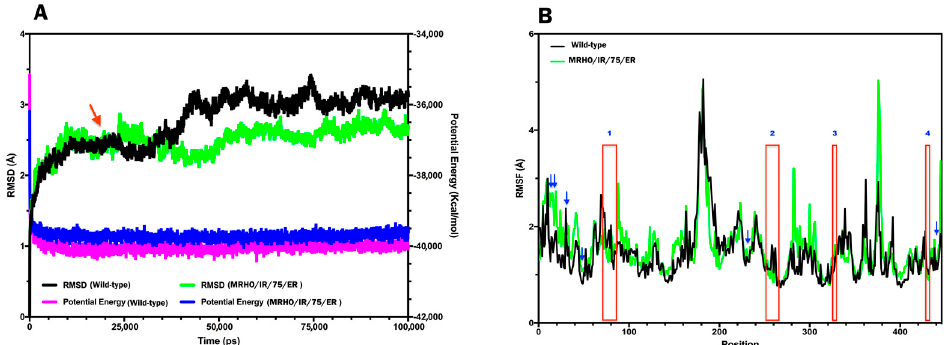
Figure 6. C α RMSD and Potential energy plot of the wild-type (black and purple) and strain MRHO/IR/75/ER (green and blue) CYP51 proteins versus the simulation time. The RMSD lines were indicated by the arrow and drew relative to their starting structures ( A ). Comparative RMSF graph of 100 ns MD simulation of the wild-type (black) and strain MRHO/IR/75/ER (green) CYP51 backbone atoms. Red boxes demonstrate the approximate location of active site pocket residues. Locations of the mutations were indicated by the arrows ( B ).